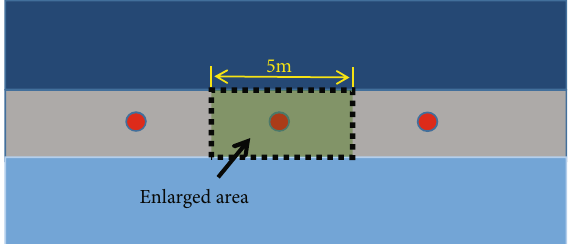
Figure 6: Research area of single borehole broken soft coal